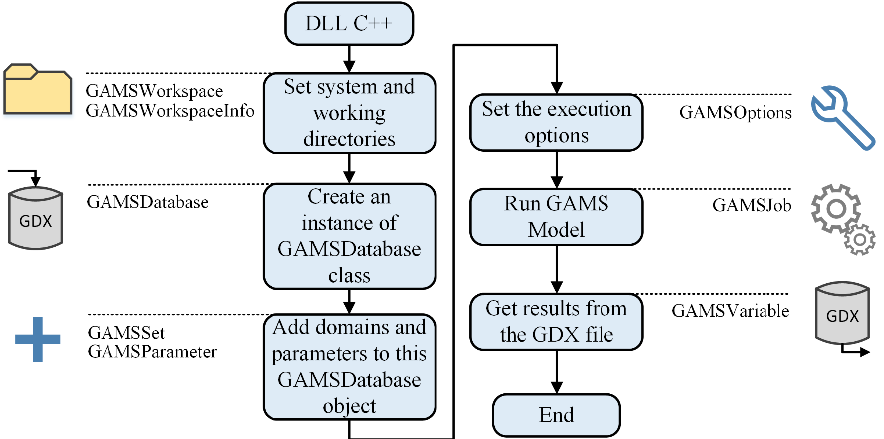
Figure 3. Dynamic-link library (DLL) flowchart for linking both environments.